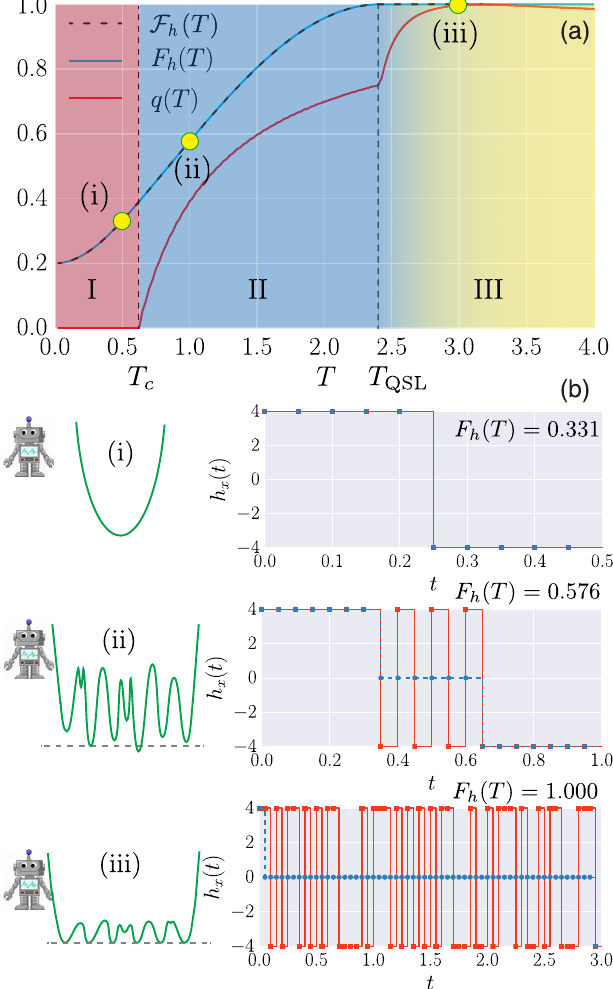
FIG. 1. (a) Phase diagram of the quantum-state manipulation problem for the qubit in Eq. (3) vs protocol duration T , as determined by the order parameter q ð T Þ (red) and the maximum T Þ (blue) compared to the possible achievable fidelity F h ð T Þ (black, dashed). Increasing the total variational fidelity F h ð protocol time T , we go from an overconstrained phase I, through a glassy phase II, to a controllable phase III. (b) Left: The infidelity landscape is shown schematically (green). Right: The optimal bang-bang protocol found by the RL agent at the points (i) – (iii) (red) and the variational protocol [62] (blue,